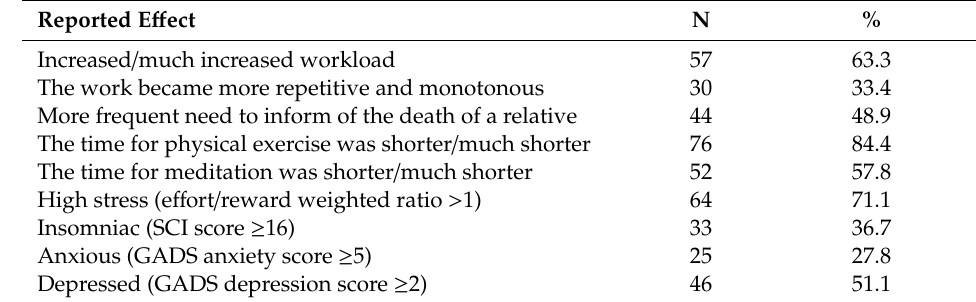
Table 2. Changes reported during the COVID-19 outbreak, and prevalence of high stress, insomnia, anxiety, and depression in